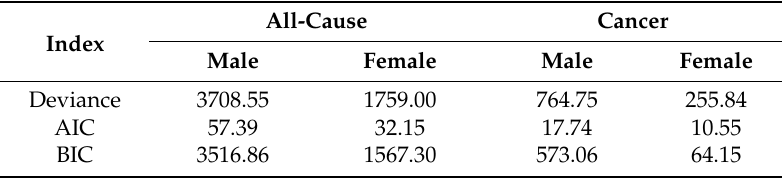
Table A3. Goodness-of-fit measurements of APC